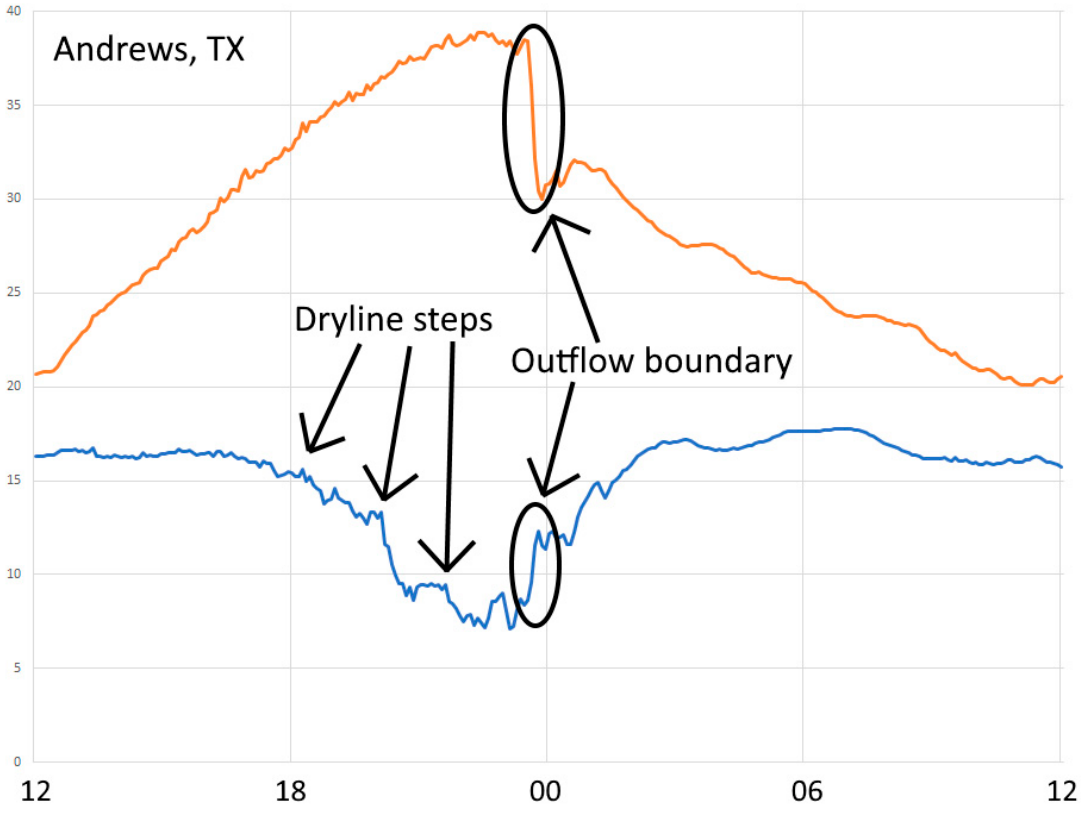
Figure 17. Time series plots of temperature (red) and dew point (blue; C) between 1200 UTC 12 June and 1200 UTC 13 June at Andrews, Texas.